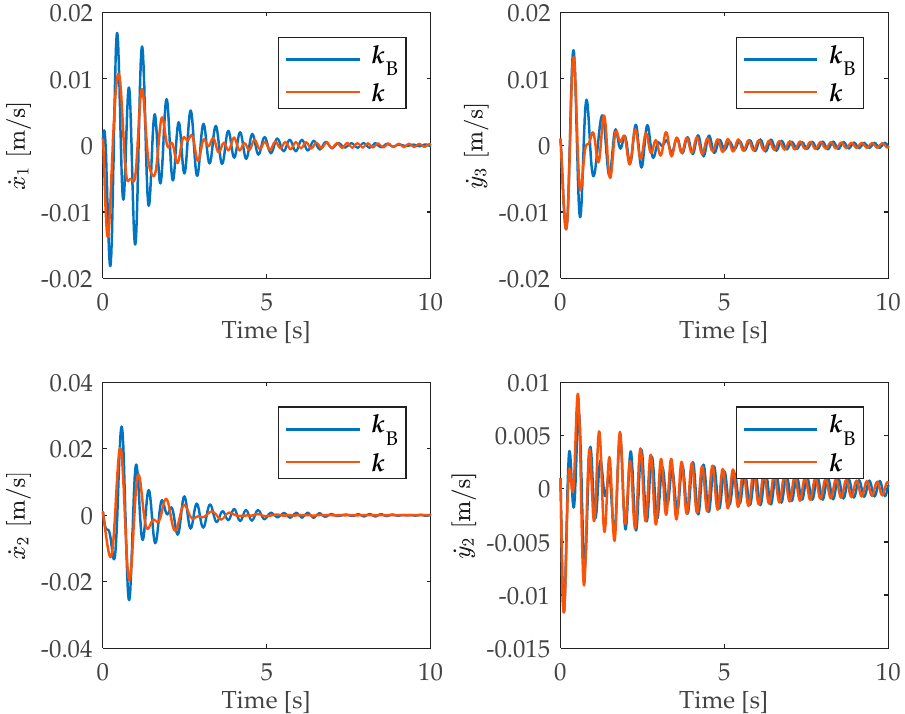
Figure 5. Velocities of the controlled system comparison: traditional PPP and the proposed method (test-case 2).